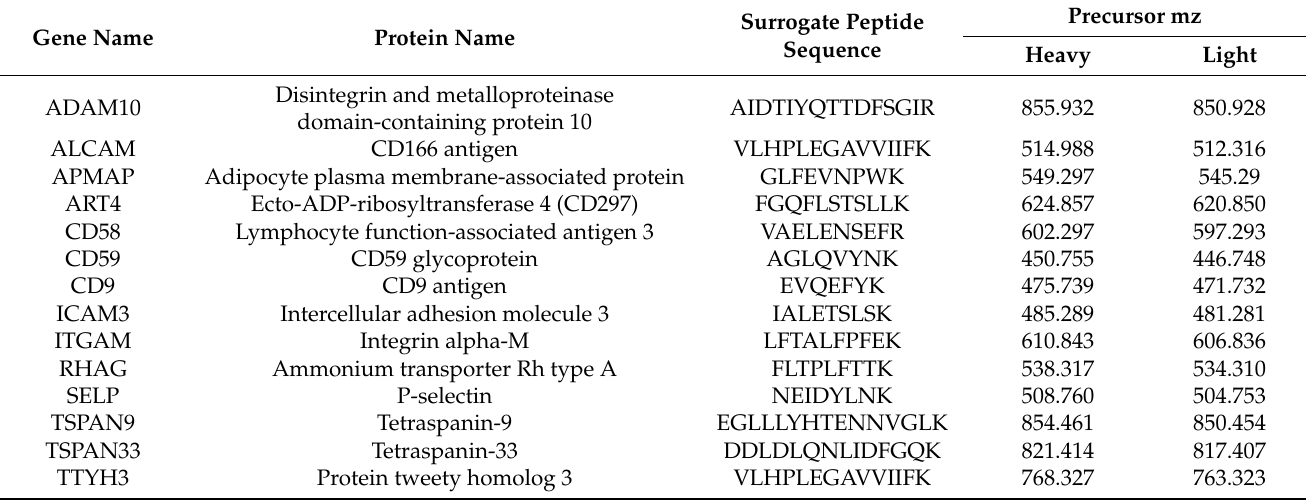
Table 1. List of candidate proteins selected for a verification study in individual samples by targeted MS